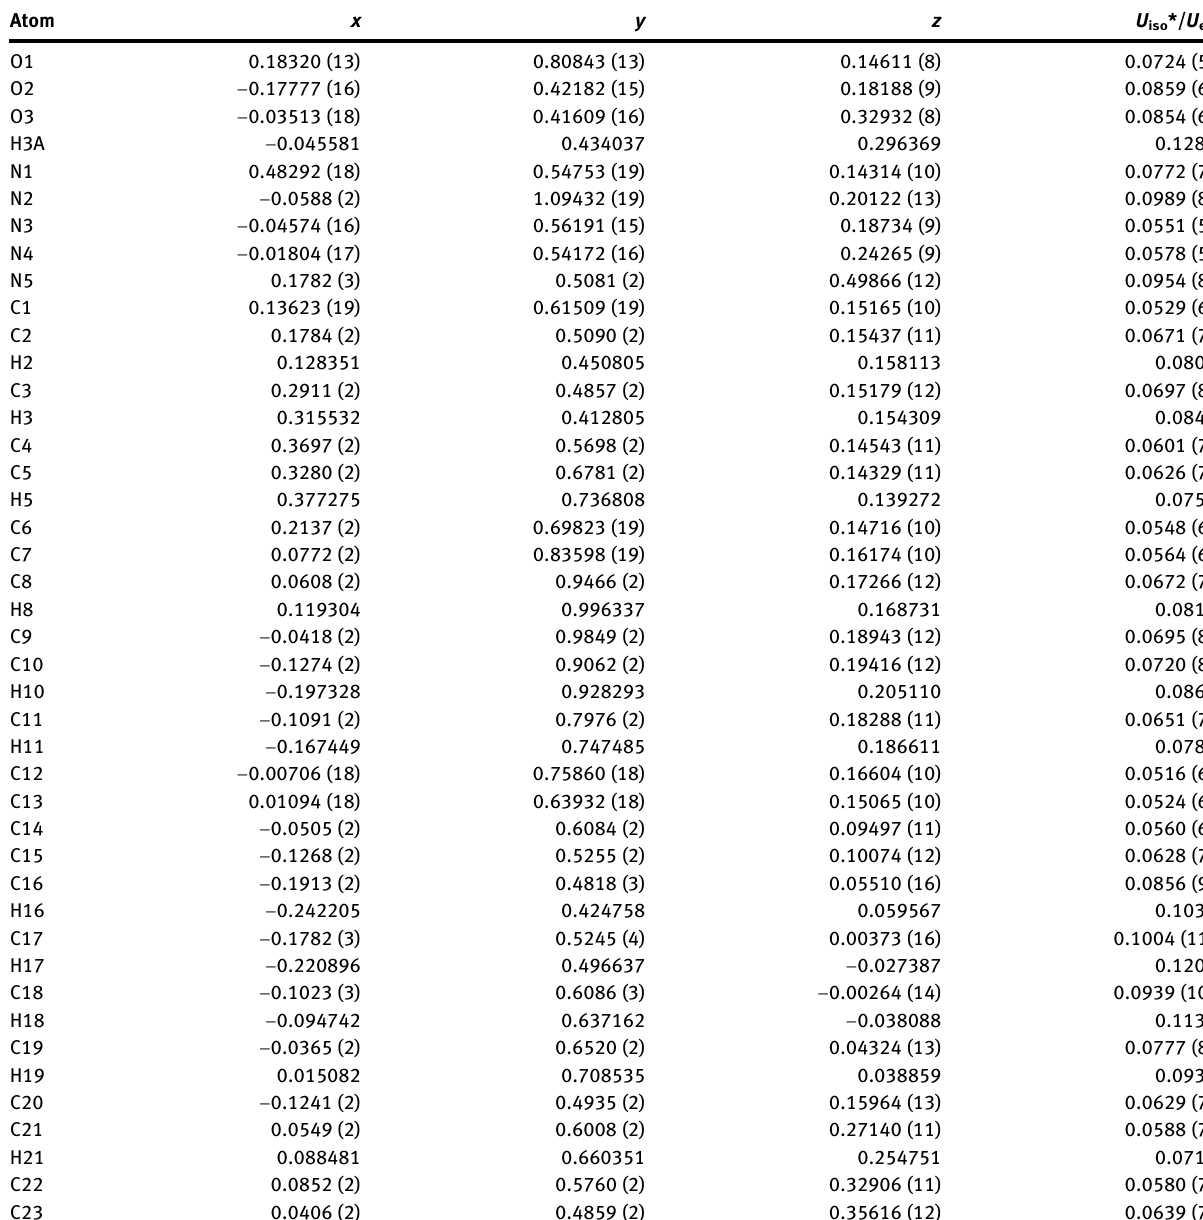
Table  : Fractional atomic coordinates and isotropic or equivalent isotropic displacement parameters (Å 